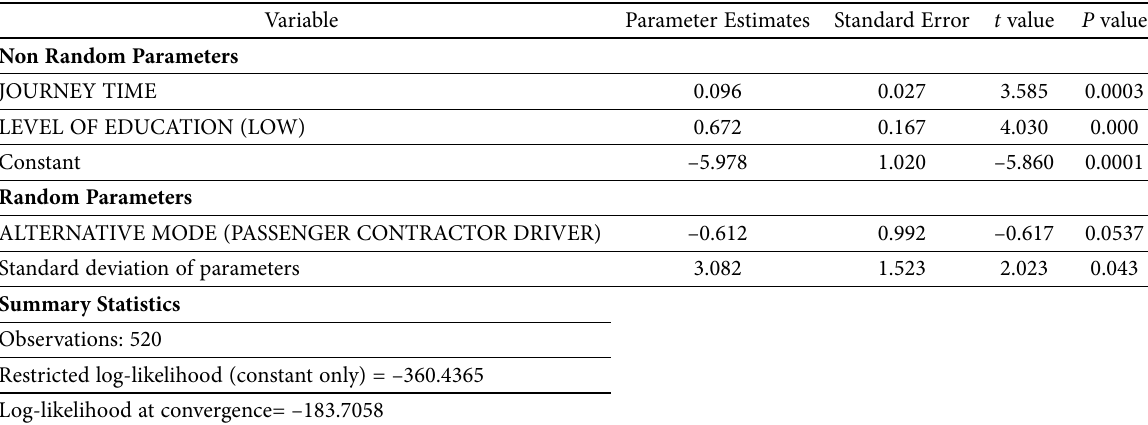
Table 6. Mixed logit model estimation results for ‘FEMALE INFORMAL CAR